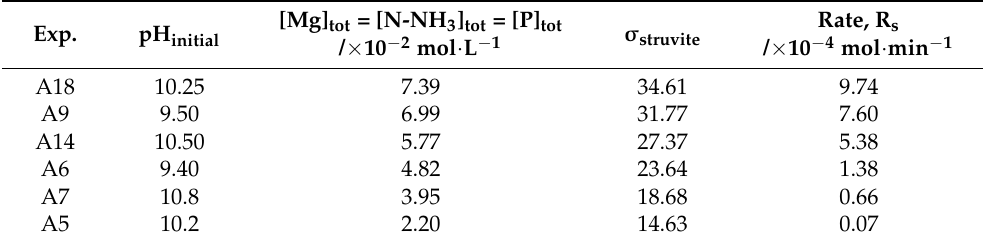
Figure 3. ( a ) Magnesium concentration as a function of time during the precipitation of struvite and ( b ) change in pH for struvite precipitation; the magnesium source was the suspension obtained for the hydrothermal treatment of MgO (Method A); 25 °C.